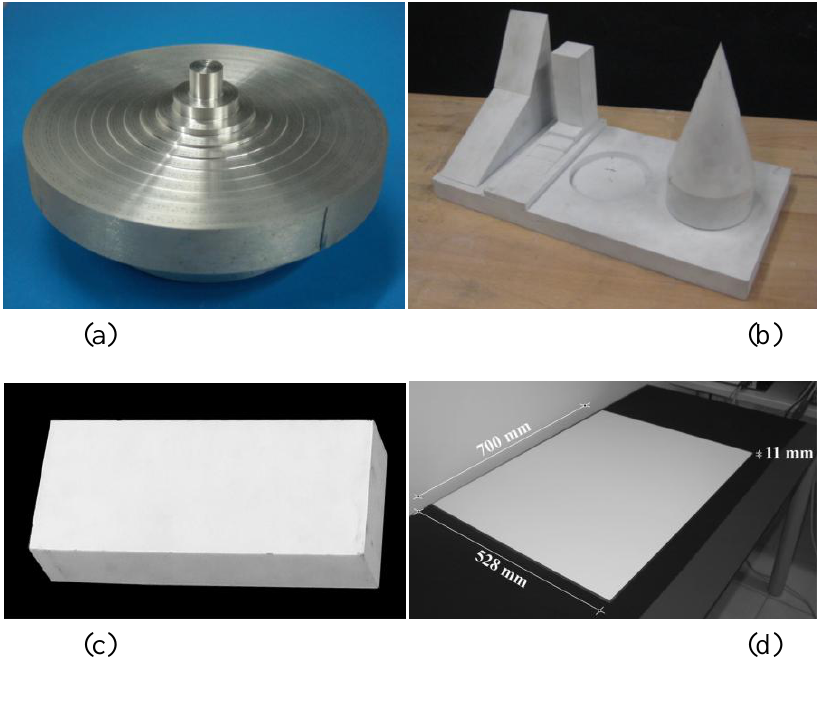
Figure 3. Test objects used in the experiments: (a) set of steps for testing z resolution and accuracy; (b) set of solids for testing accuracy and uncertainty; (c) parallelepiped block for testing xy resolution; (d) reference plane for testing uncertainty and relative